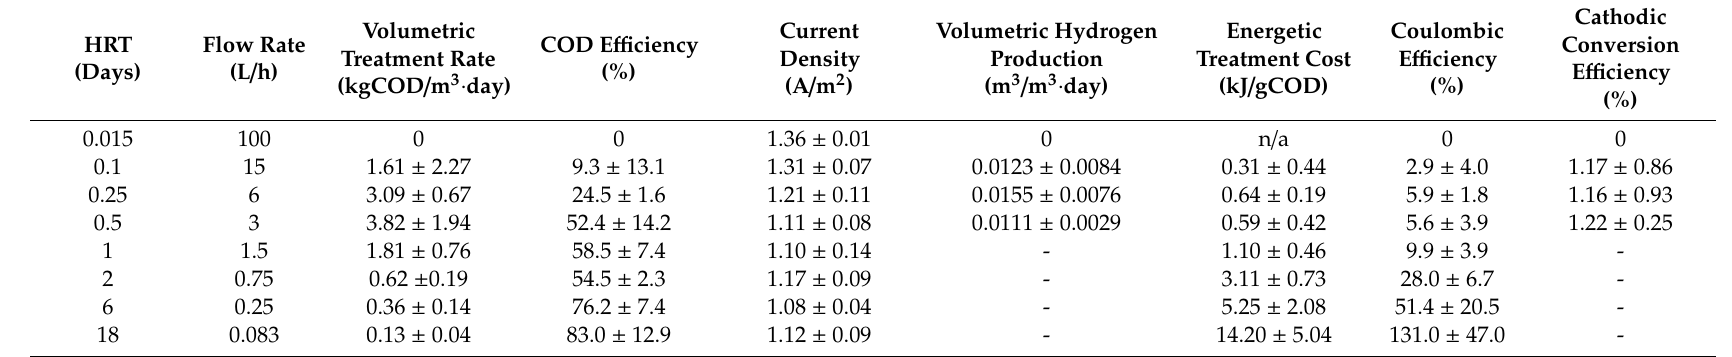
Table 2. Average performance indicators for each hydraulic retention time (HRT). For hydrogen production values, averages have been taken from HRTs prior to